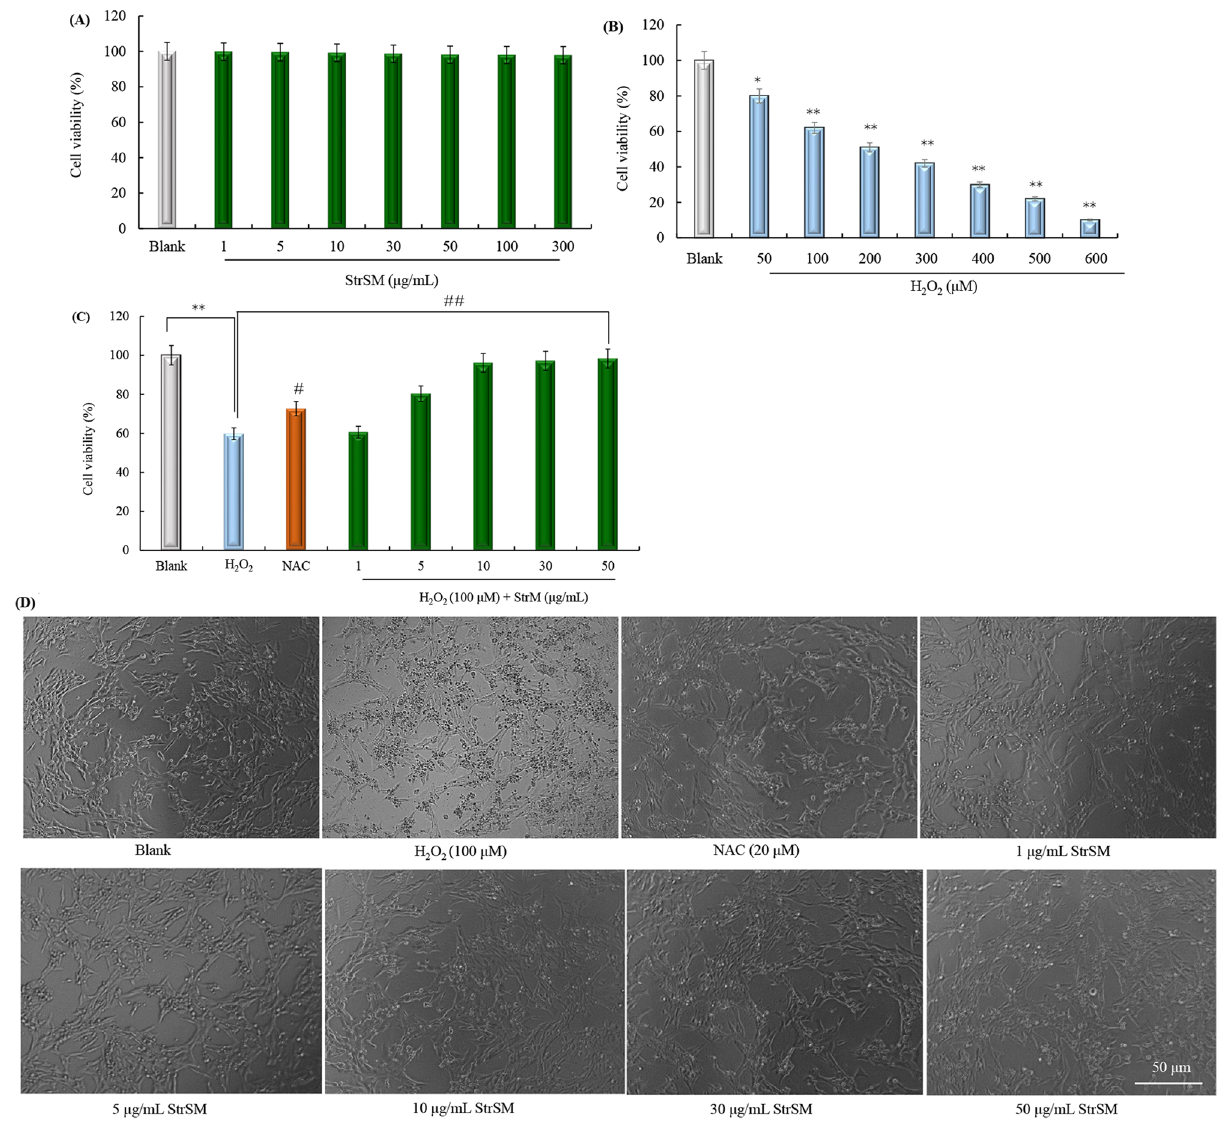
Figure 5. StrSM protects SH-SY5Y cells against H 2 O 2 -induced oxidative injury. ( A ) Cells are treated with various concentrations of StrSM. ( B ) Cells are treated with various concentrations of H 2 O 2 for 24 h. ( C ) Cells are pre-treated with various concentrations of StrSM for 5 h followed by co-treatment with 100 µM H 2 O 2 for 24 h and their viability. ( D ) The protective effect of StrSM on H 2 O 2 -induced morphological changes in SH-SY5Y cells. Cells are observed under 100 × magnification. Scale bar = 50 μm. Data are presented as mean ± standard deviation of three independent experiments. * p ≈ 0.02 < 0.05, ** p ≈ 0.005 < 0.01, # p ≈ 0.03 < 0.05, and ## p ≈ 0.002 < 0.01 are determined using one-way ANOVA and Dunnett post hoc test. NAC, N -acetylcystein; StrSM, melanin from Streptomyces sp. StrSM protects H O ‑induced cell injury in SH‑SY5Y cells. 2 2